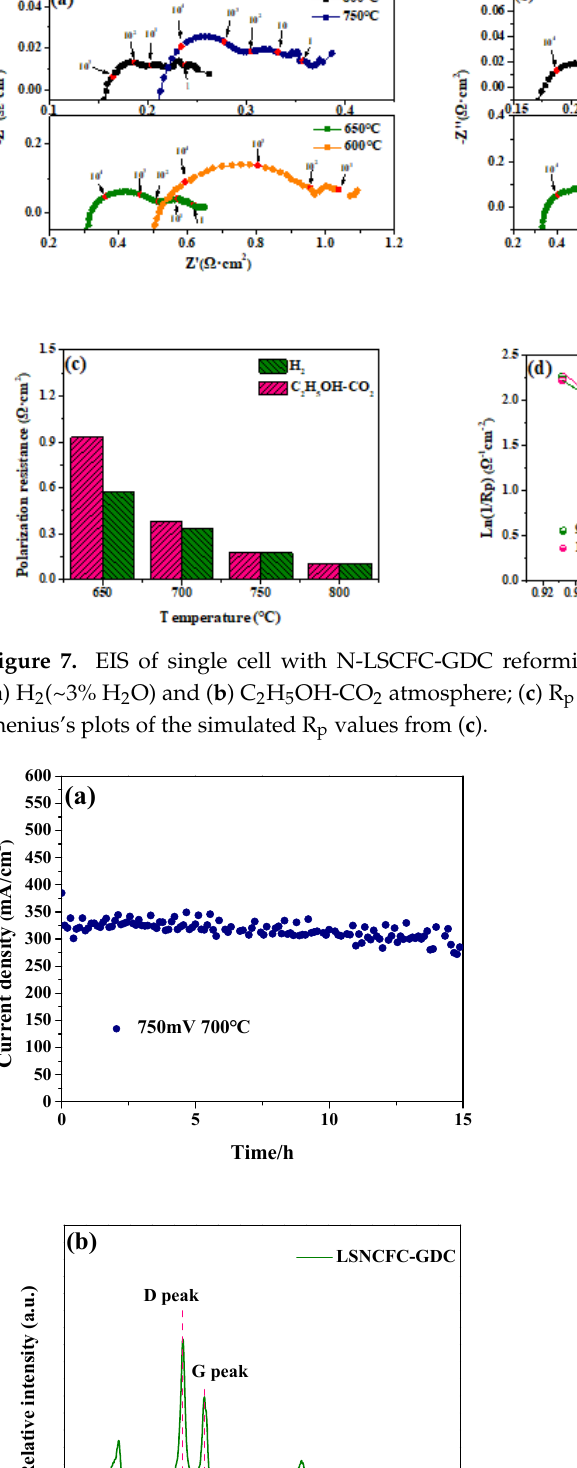
Figure 8. ( a ) The stability of single cell exposed to 50% CO 2 -50% C 2 H 5 OH; ( b ) Raman spectra curves of single cell with N-LSCFC-GDC reforming catalyst after exposure to 50% CO 2 -50% C 2 H 5 OH at 700 °C for 15 h.